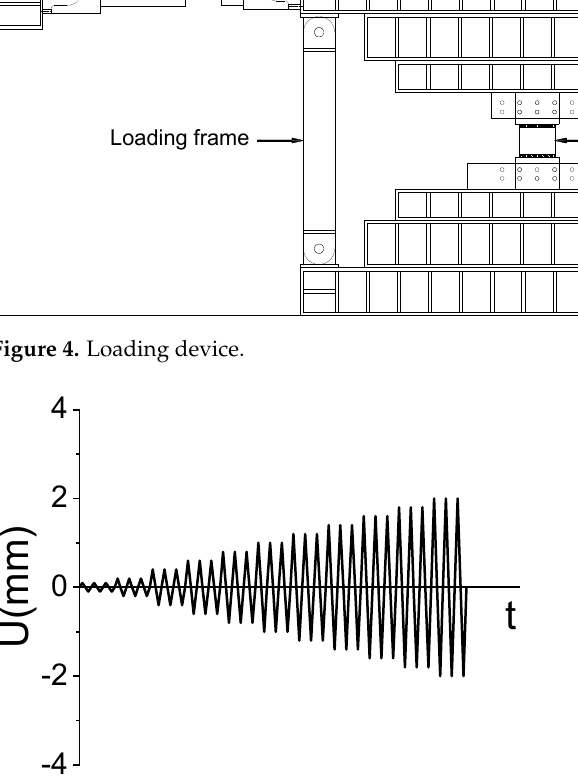
Figure 5. Loading scheme.